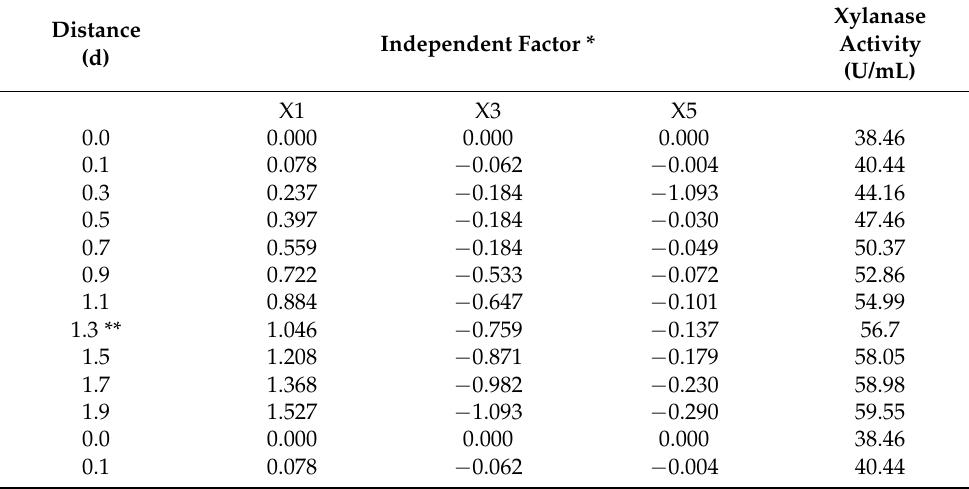
Table 3. The estimated ridge of xylanase activity produced by P. chrysogenum strain A3 DSM105774 through the steepest ascent path of ridge